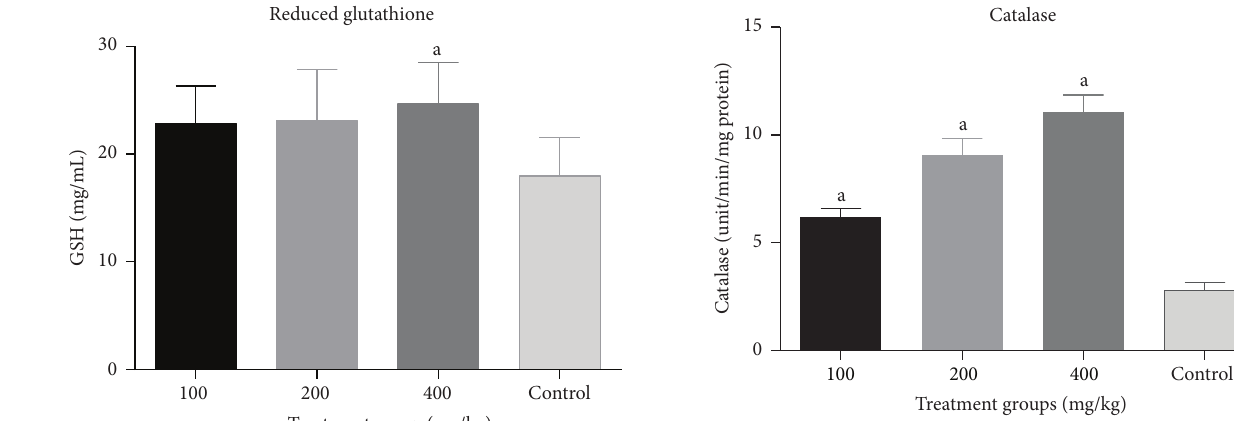
Figure 8: Effect of combined aqueous extracts of Azadirachta indica and Khaya senegalensis on reduced glutathione (GSH) levels of the liver of healthy chickens. Values are expressed as mean ± SEM where 𝑛 = 5 . a S ignificant as compared with control ( 𝑝 < 0.05 ).